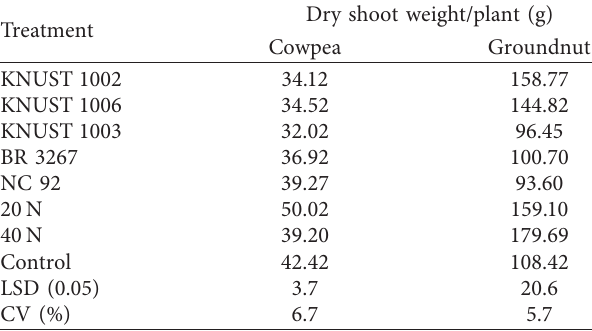
Table 1: Effects of rhizobial inoculation and N fertilizer application on shoot dry weights of cowpea and groundnut grown at Nyankpala in the Guinea Savanna zone of Ghana. Nodule number and nodule dry